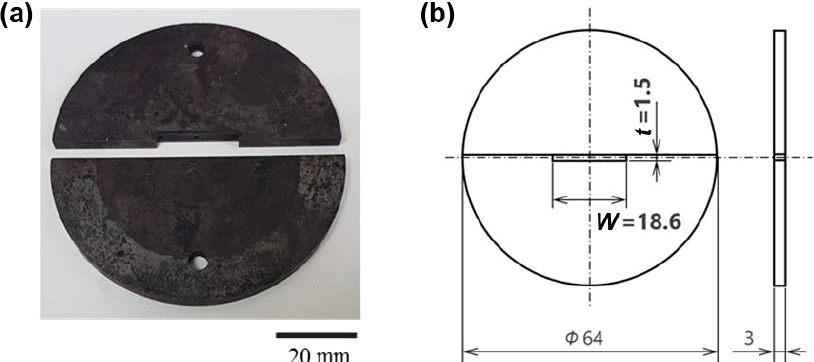
Fig. 2 Shape of segmented die ((a) picture and (b)